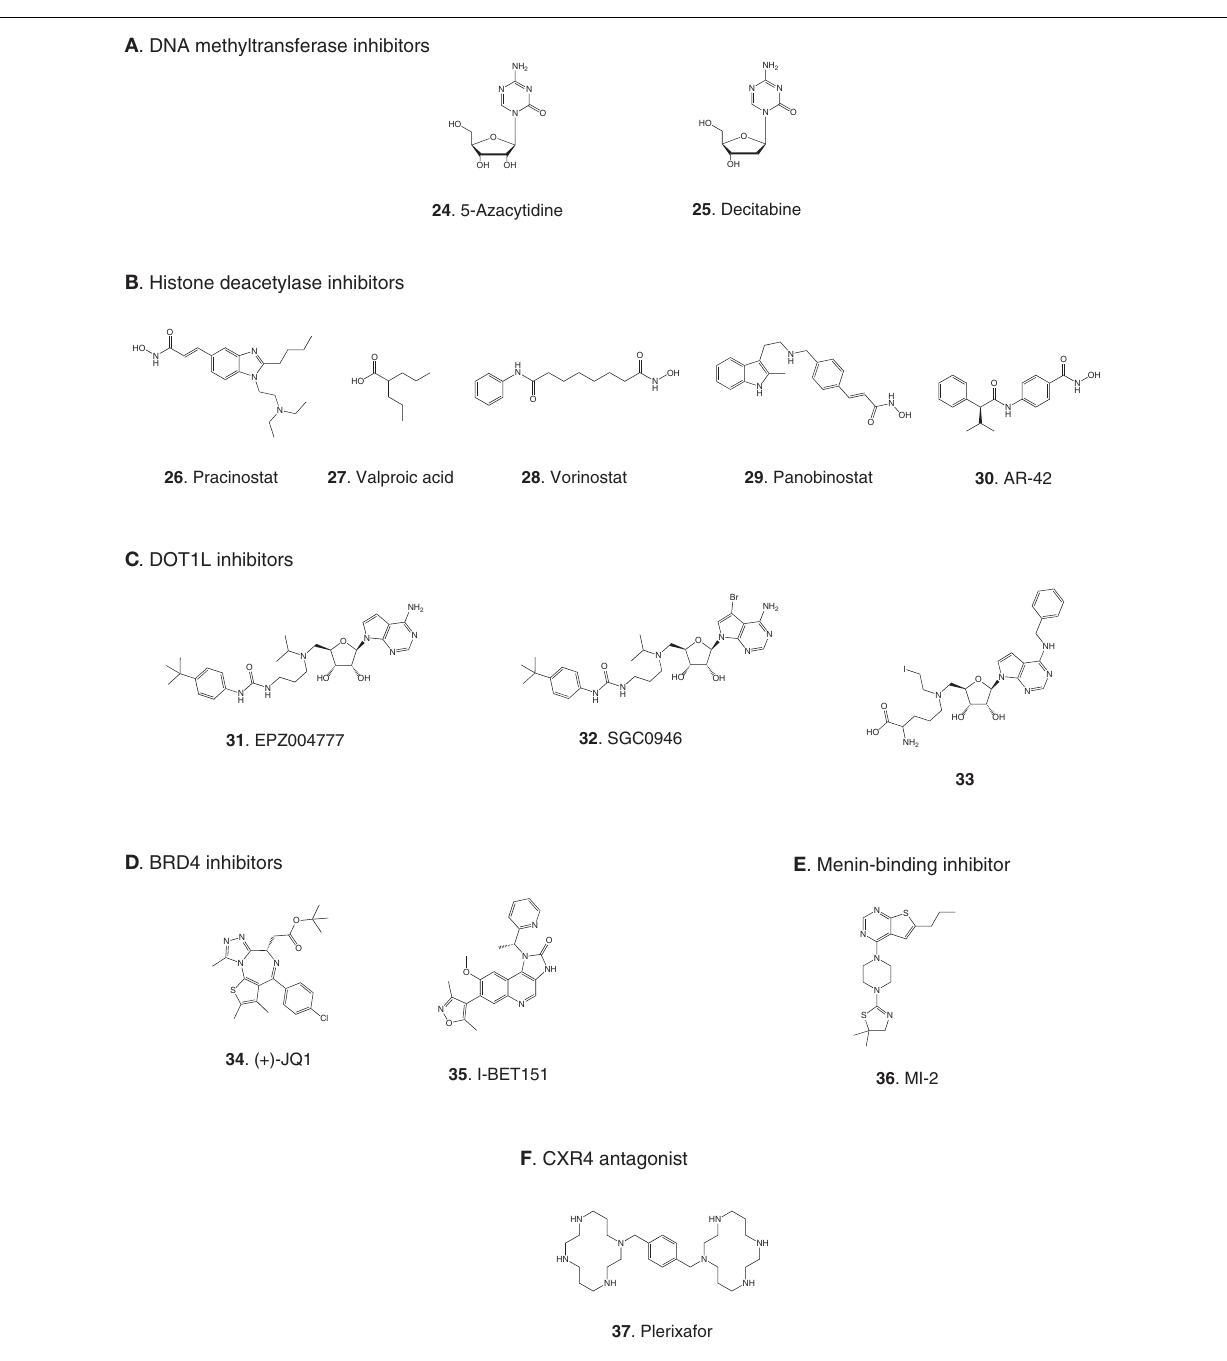
FIGURE 3 | Compounds targeting transcription or stem cell homing . Numbers in bold type are used to refer to compounds in this figure from the main text, Figure 5 , and Table 1 . (A) DNA methyltransferase inhibitors, (B) histone deacetylase inhibitors, (C) DOT1L inhibitors, (D) BRD4 inhibitors, (E) Menin-binding inhibitor, (F) CXCR4